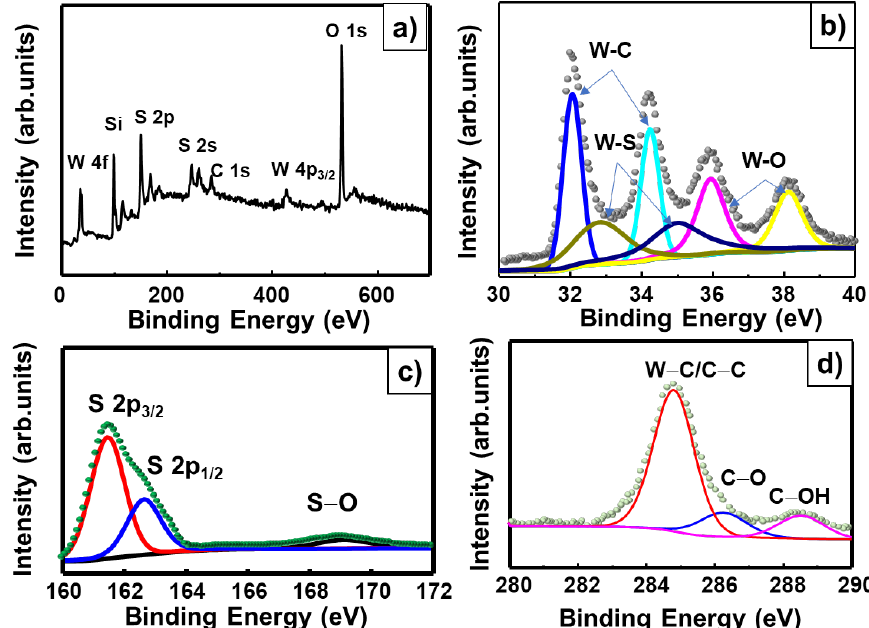
Figure 4. XPS profiles of the W 2 C / WS 2 _4h NF sample with ( a ) survey scan spectrum and high-resolution ( b ) W 4f, ( c ) S 2p, and ( d ) C 1s spectra. 164